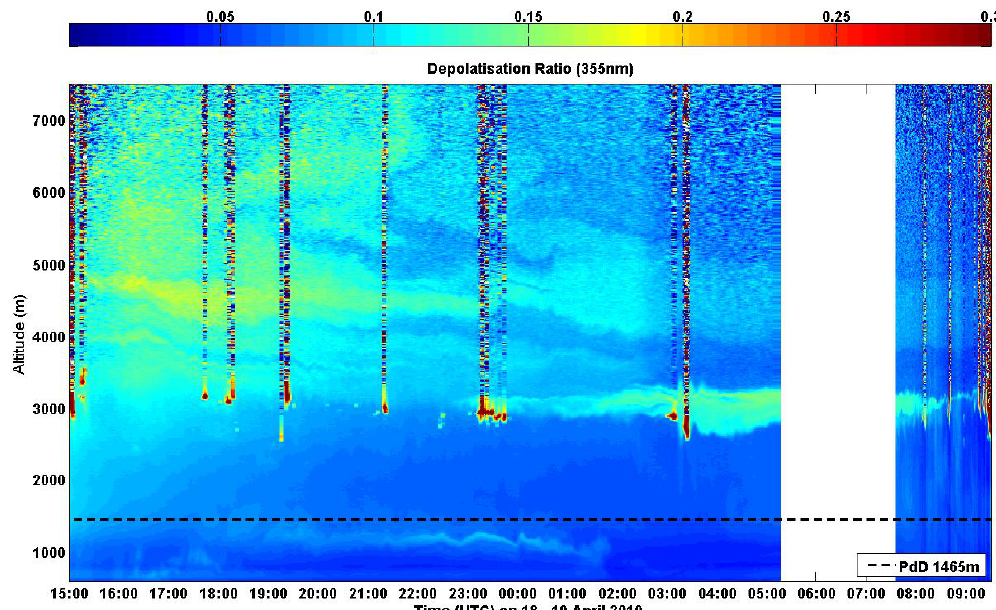
Fig. 9. Time series of the colour-coded volume depolarization ratio as a function of altitude for 18 to 19 April 2010. The black dotted line corresponds to the altitude of Puy de